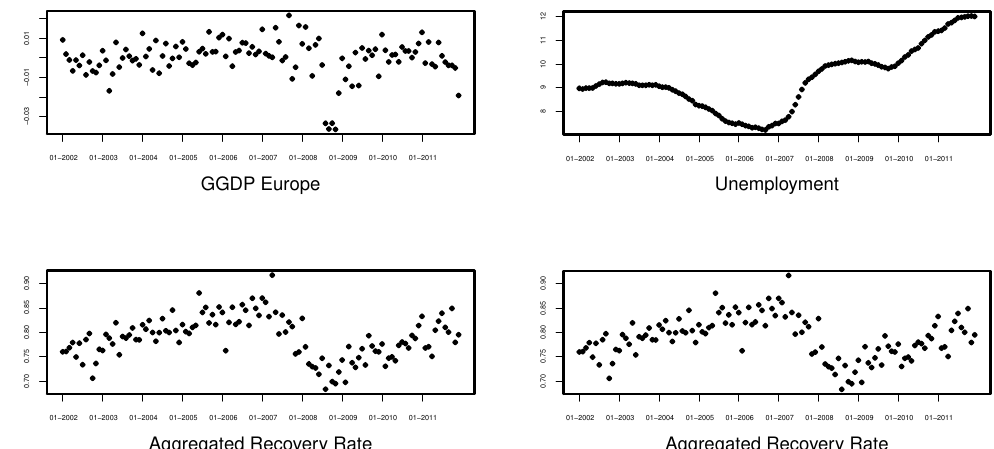
Figure 8. Shifted European GGDP ( top left ) and Unemployment ( top right ) vs. recovery rate ( bottom